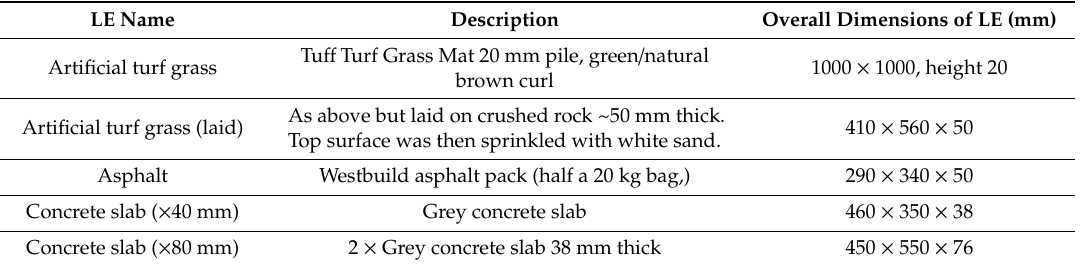
Table 1. Description of landscape elements (LEs) used in the phase 1 seasonal